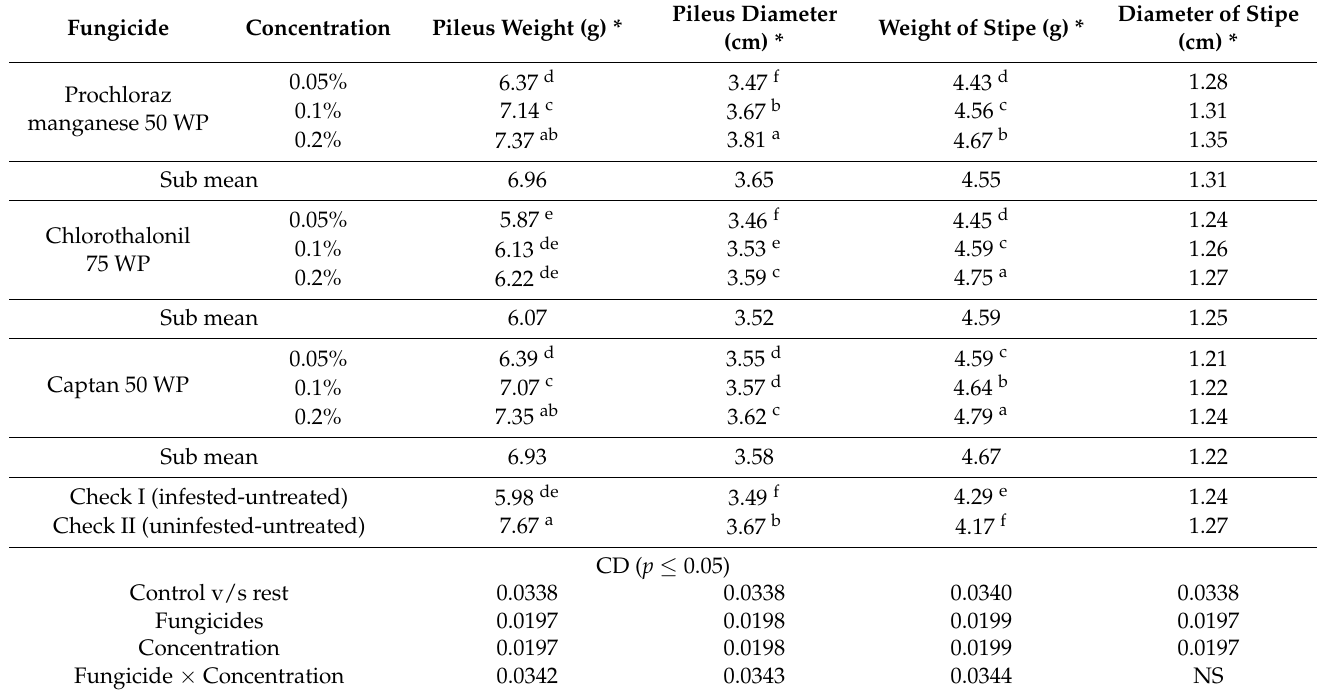
Table 6. Impact of non-systemic fungicides on T. harzianum infested casing pooled during spring 2017 and 2018 on quality parameters of A. bisporus.